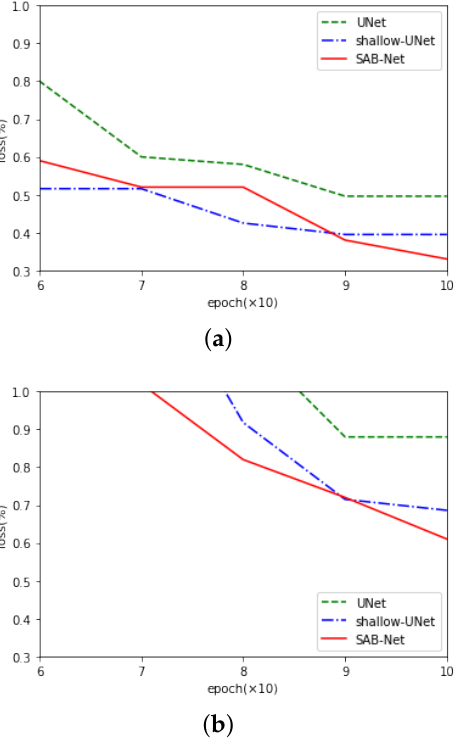
Figure 7. ( a ) Progress of the training procedure and ( b ) the validation loss with the number of epochs when conducting training on the Heart MRI dataset. Green: U-Net. Blue: shallow-UNet. Red: